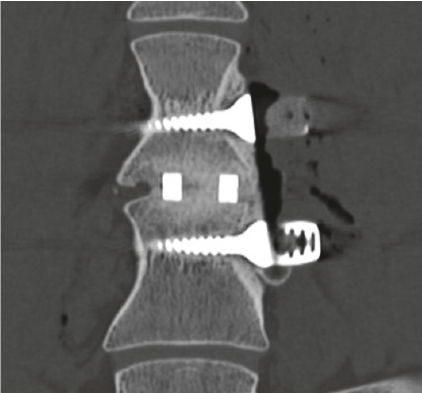
Figure 12: 4-month CT scan survey of explanted combustion synthesis porous Nitinol material exhibiting complete through growth of bone after four months of implantation in an ovine study.